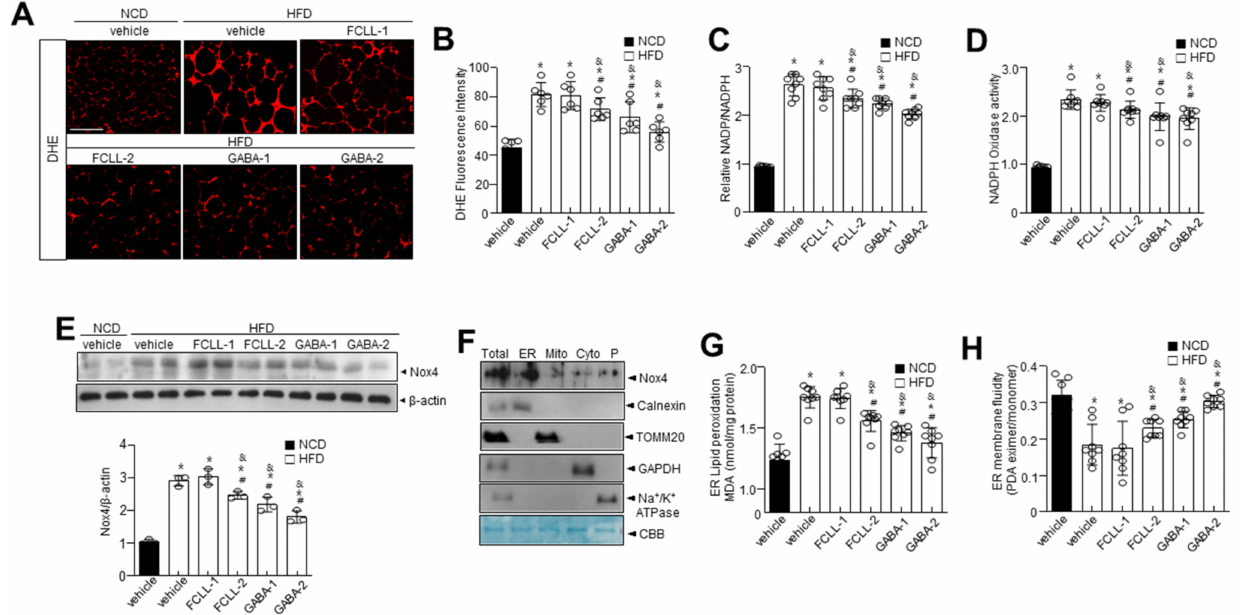
Figure 6. GABA and fermented Curcuma longa L. extract enriched with GABA regulate oxidative stress and ER redox imbalance in HFD model. Mice received vehicle or GABA and GABA-enriched Curcuma longa L. extract (1 or 2 g/kg) once daily for 14 weeks by oral gavage. Representative dihydroethidium (DHE)-stained images depicting ROS production ( A ) and quantification ( B ) in each condition. Scale bars = 100 µ m. eWAT lysates were analyzed for NADP/NADPH ratio ( C ) and NADPH oxidase activity ( D ). ( E ) Expression of Nox4 and β -actin in eWAT and respective quantitative analysis of protein expressions. ( F ) Subcellular fractions of lysates were analyzed by immunoblotting. ( G ) eWAT lysates were analyzed for lipid peroxidation levels. ( H ) Analysis of membrane fluidity in the ER fraction. Data are presented as mean ± SEM ( n = 8, * p < 0.05 vs. NCD + vehicle, & p < 0.05 vs. HFD + FCCL-1, # p < 0.05 vs. HFD + vehicle). NCD, normal chow diet; HFD, high-fat diet; FCLL-1 and FCLL-2, HFD fed mice received 1 and 2 g/kg fermented Curcuma Longa L. enriched with GABA (FCLL-GABA), respectively; GABA-1 and GABA-2, HFD fed mice receiving 1 and 2 g/kg GABA,